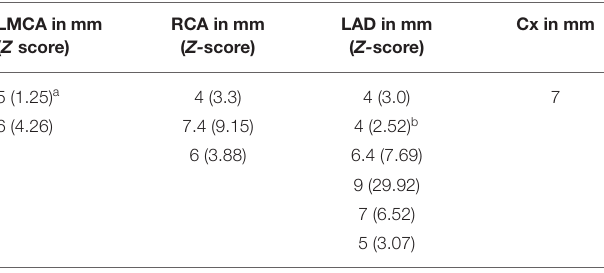
TABLE 3 | CAAs missed by CMR, with accompanying Z- scores calculated from the luminal diameters acquired by